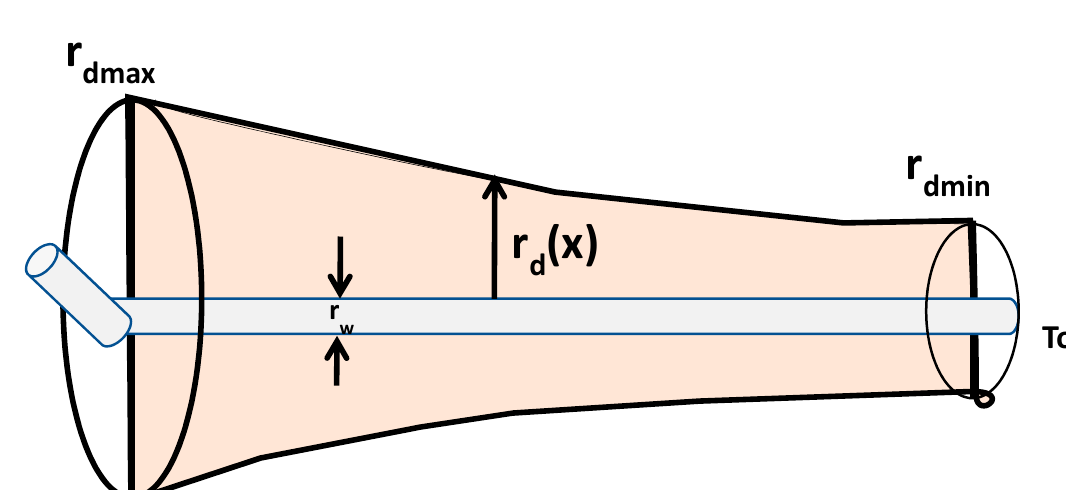
Figure 2. Cone ‐ shaped damage.